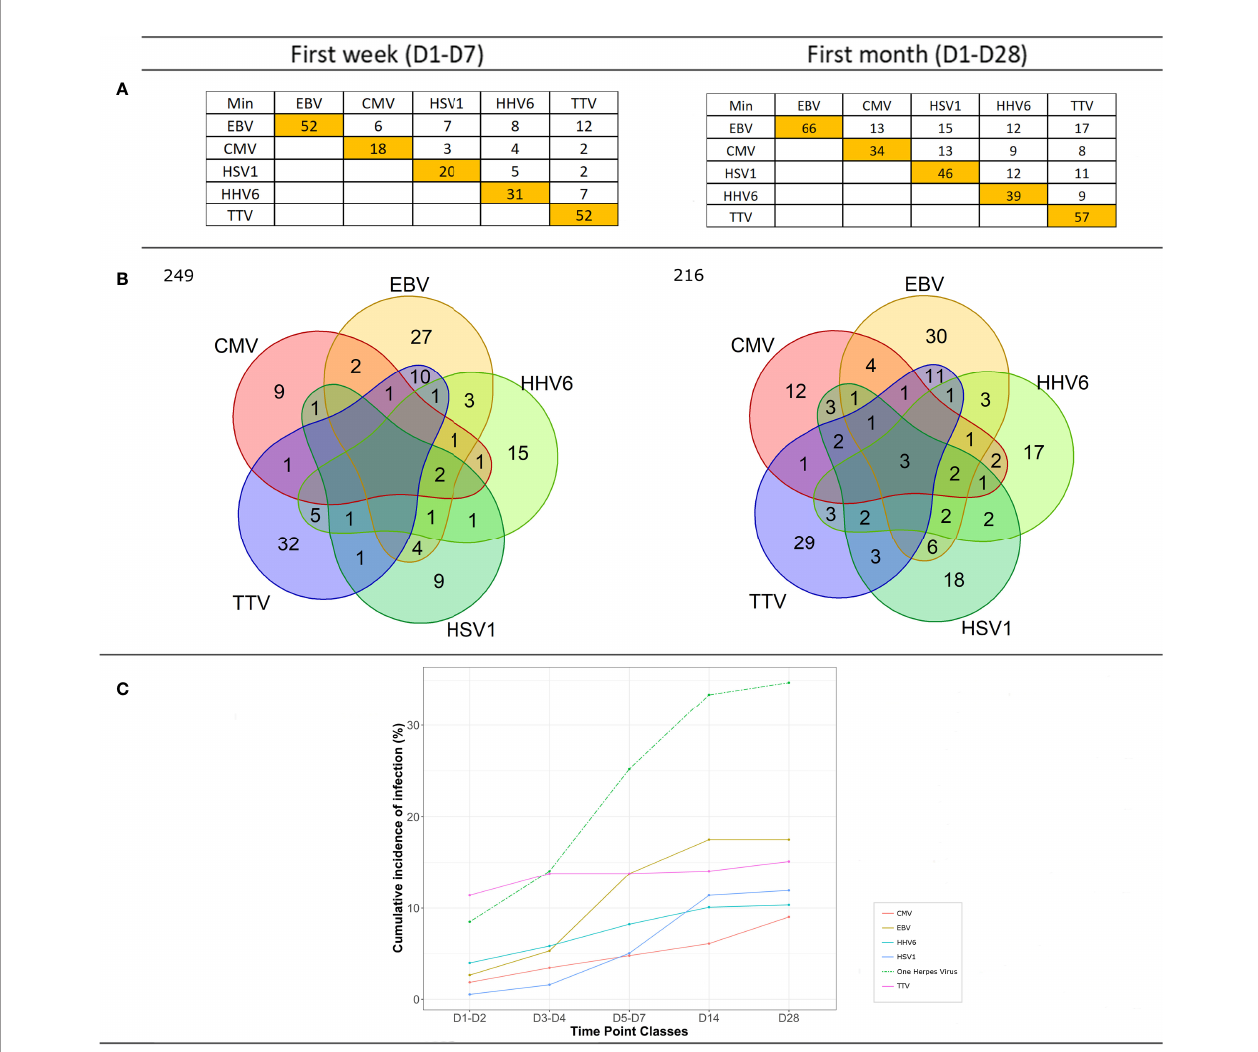
FIGURE 1 | DNAemia during the fi rst week and fi rst month following admission. (A) Number of patients presenting single- or multiple-positive herpes and/or TTVh (>10,000 copies/ml) viral DNAemia during the fi rst 7 days or the fi rst 28 days following admission in the ICU. Occurrence of each type of herpesvirus (HV) or TTVh is depicted in the orange boxes. Co-occurrence of HV with other HV or TTVh is reported in white boxes. (B) Venn diagram illustrating single versus multiple viral reactivations; 121 then 94 patients presented with no viral event during the fi rst week and the month, respectively. (C) Cumulative incidence of individual or collective HV and TTVh DNAemia at days 1 – 2, 3 – 4, 5 – 7, 14, and 28 following admission in the